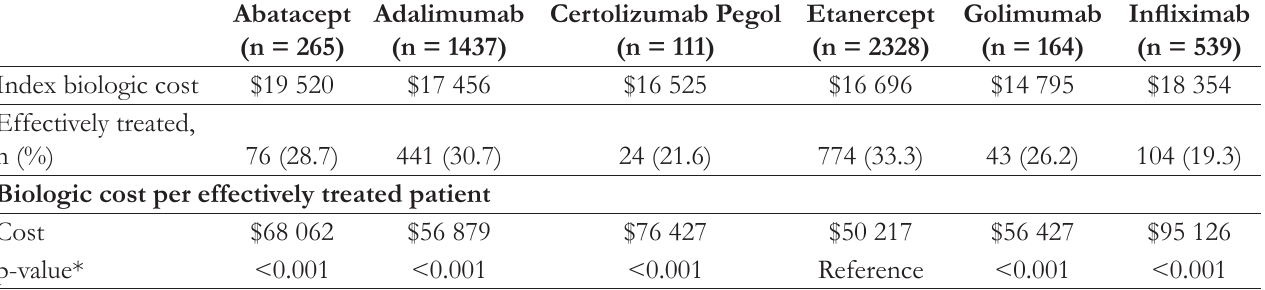
Table 3. Biologic Cost and Effectiveness per the Algorithm in Patients With Rheumatoid